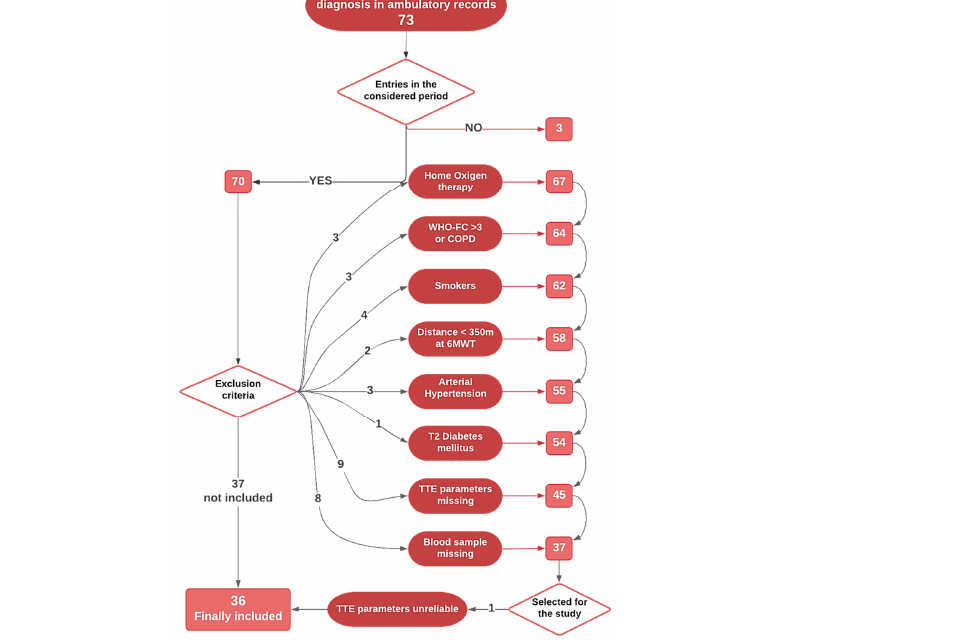
Figure 1. Flow diagram for inclusion/exclusion path. 73 records found regarding female patients with diagnosis confirmed of SSc; 3 patients did not have entries relating to the period considered; 3 had started O2 therapy; 9 had COPD, or were assigned to WHO FC >3, or were smokers, or walked a distance <350 m; 4 subjects were excluded due to relevant comorbidities (3 for arterial hypertension, 1 for type 2 diabetes mellitus); 9 were not eligible due to missing needed echocar- diography parameters; 8 were excluded because we did not find the blood sample stored in our bio-bank; finally, 1 patient was excluded after the primary selection because of the unreliability of echocardiography parameters.